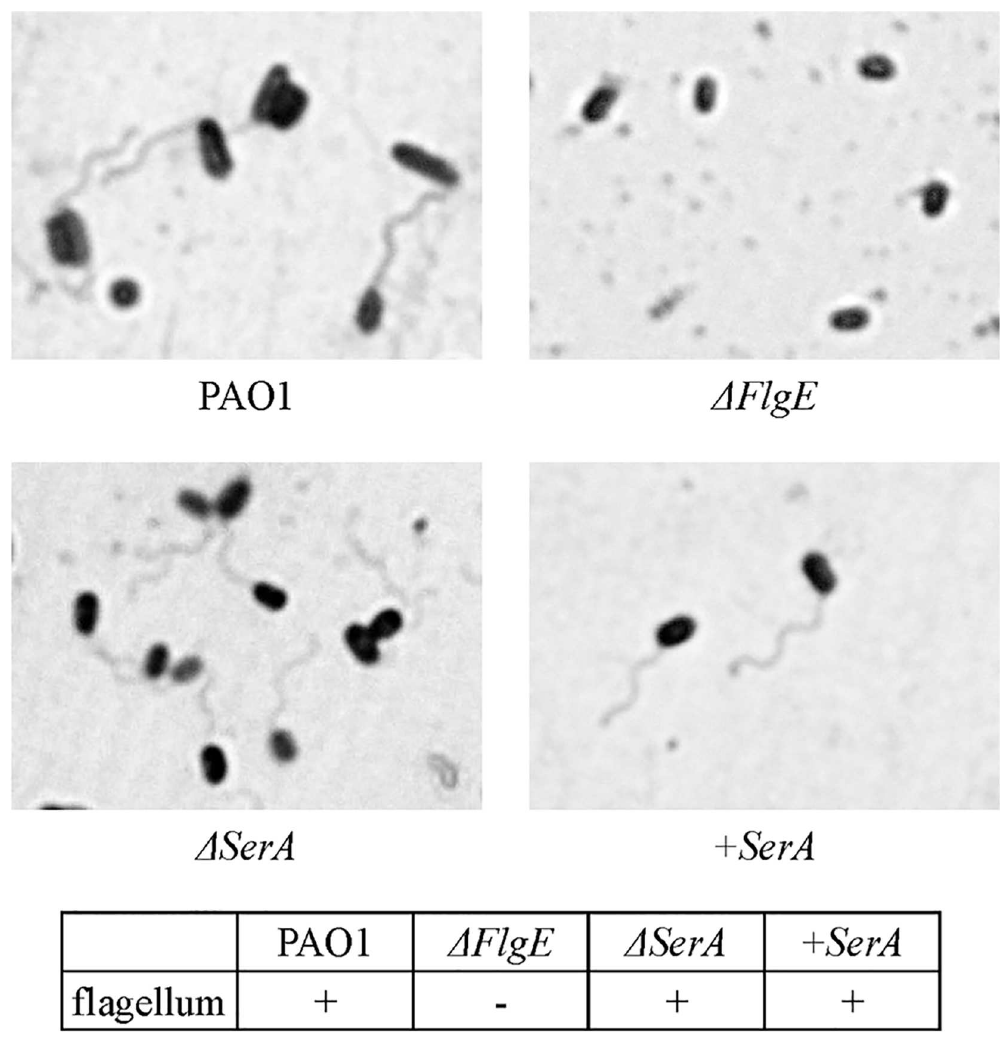
Fig 3. Staining of bacterial flagella. Flagella staining of the wild-type strain (WT), PAO1Tn:: serA mutant ( Δ serA ), PAO1Tn:: serA (pUCP19- serA ) complementary strain (+ serA ), and PAO1Tn:: flgE mutant ( Δ flgE )was performed as previously